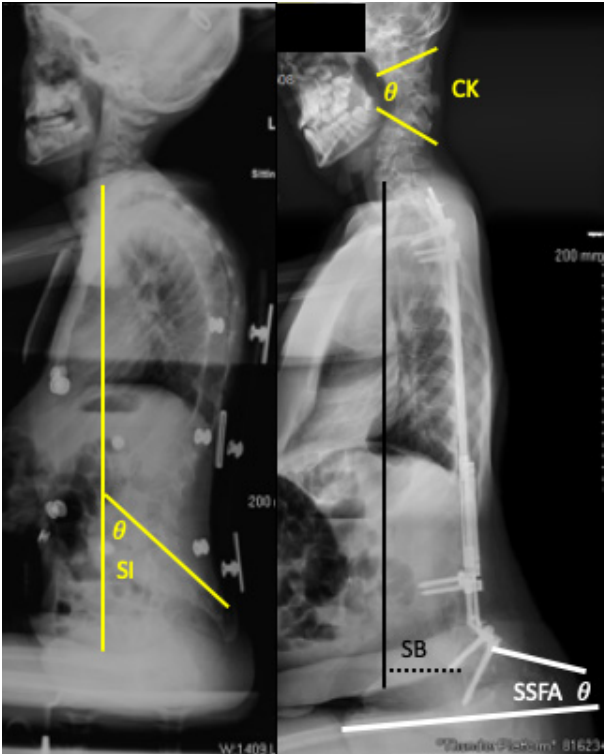
Figure 3. Examples of radiographic sagittal parameters used to objectively characterize deformities. These include Sacral Incidence (SI, Yellow); Cervical Kyphosis (CK, Yellow); Sagittal Balance (SB, Black); Seated Sacral Femoral Angle (SSFA, White).